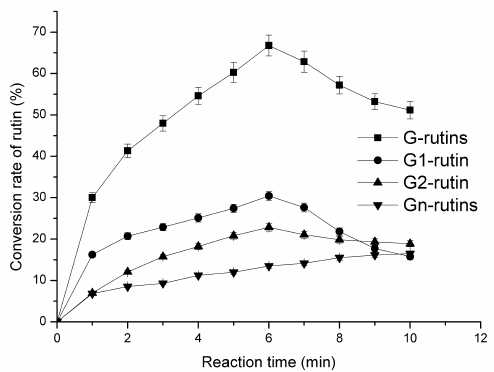
Figure 7. Time-course of the microwave-assisted method for rutin